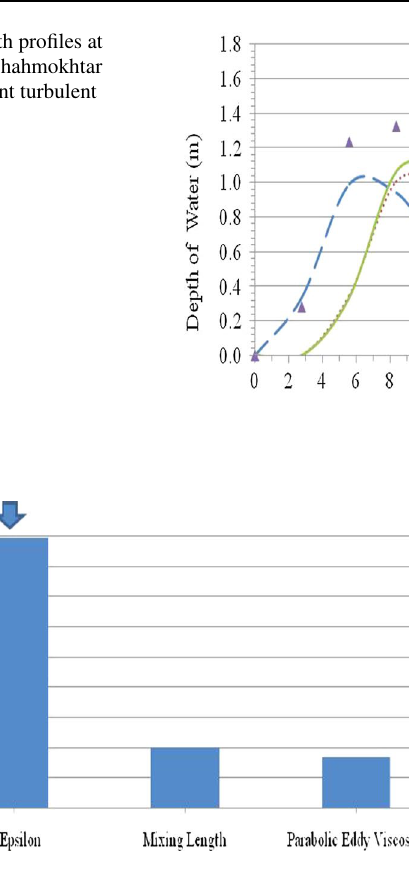
Fig. 7 The performance of the CCHE2D model for different turbulent models Fig. 8 Cross sections in a straight and meander reach of Beshar